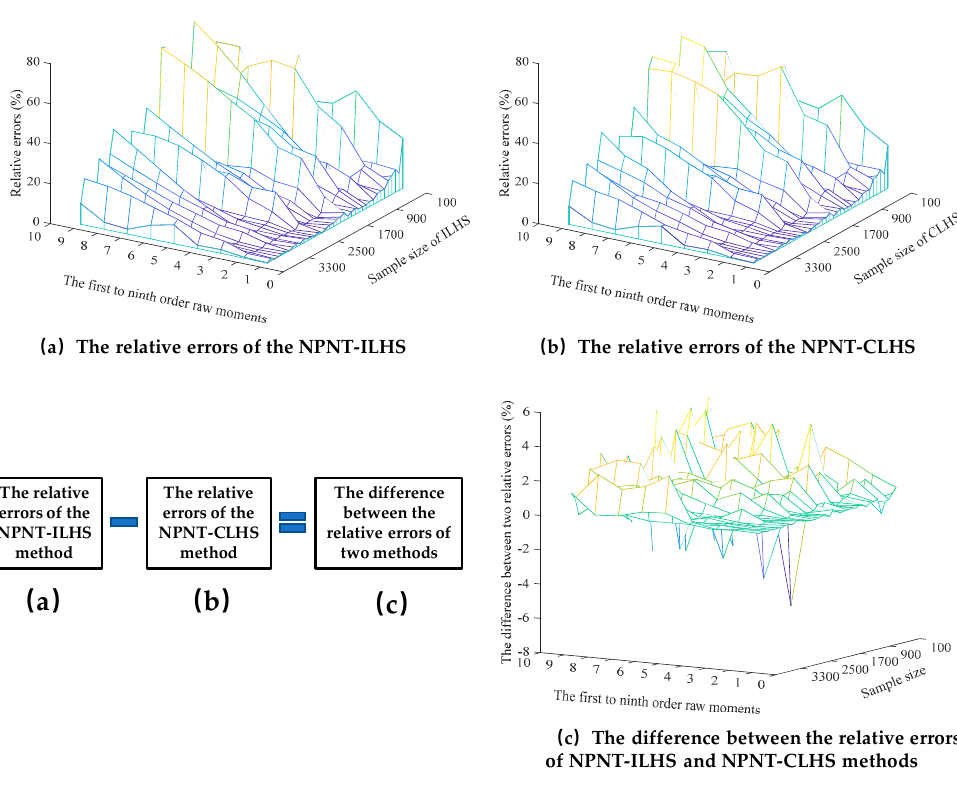
Figure 8. The relative errors of the first to ninth raw moments of VSC3 ′ s output active power obtained by using NPNT-ILHS and NPNT-conventional Latin hypercube sampling (CLHS) methods.